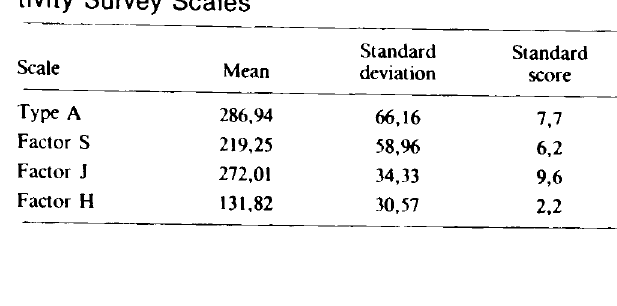
Table 3 Means, Standard Deviations and